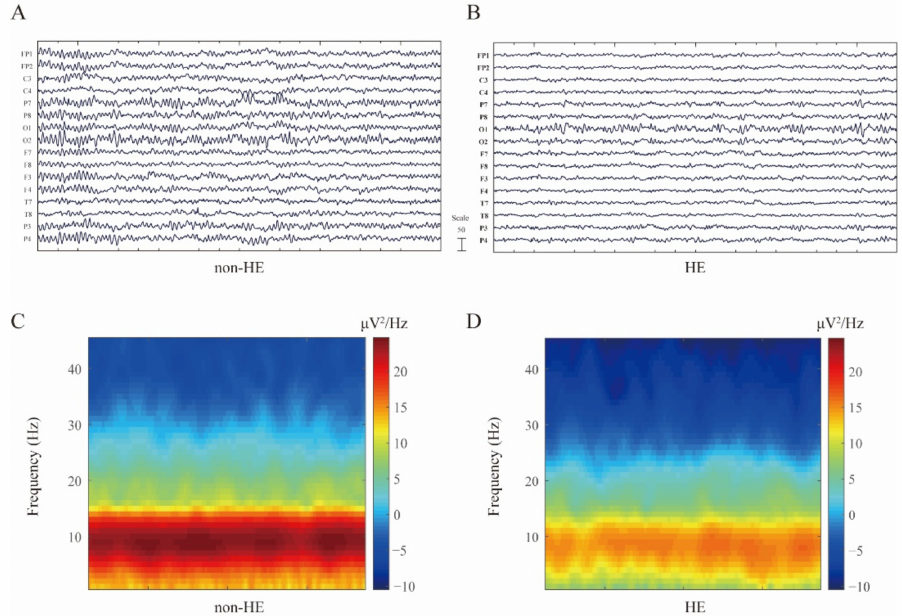
Figure 2. Comparison of EEG signal between non-HE and HE patients who received PPIs treatment. ( A ) Representative resting-state EEG traces in non-HE cohort, and ( B ) one with HE, respectively. ( C , D ) Comparison of spectrogram at distinct neurological condition (non-HE versus.